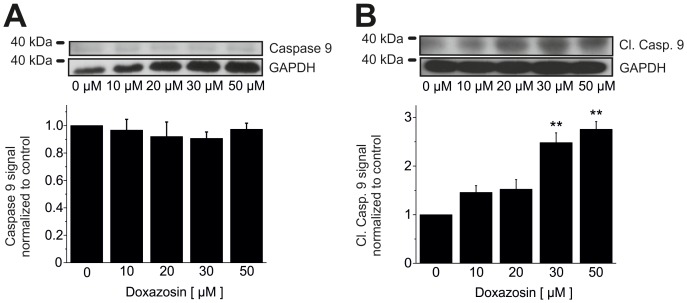
Caspase 9 activation en route to apoptosis.(A, B) Increased levels of cleaved caspase 9 and unaffected total caspase 9 protein expression were detected in LNT-229 cells treated with doxazosin. Representative Western blots and mean (± SEM) optical densities normalized to doxazosin-free conditions are presented for cells exposed to increasing concentrations of doxazosin (n = 3 independent assays; **p<0.01; GAPDH, glyceraldehyde-3-phosphate dehydrogenase).